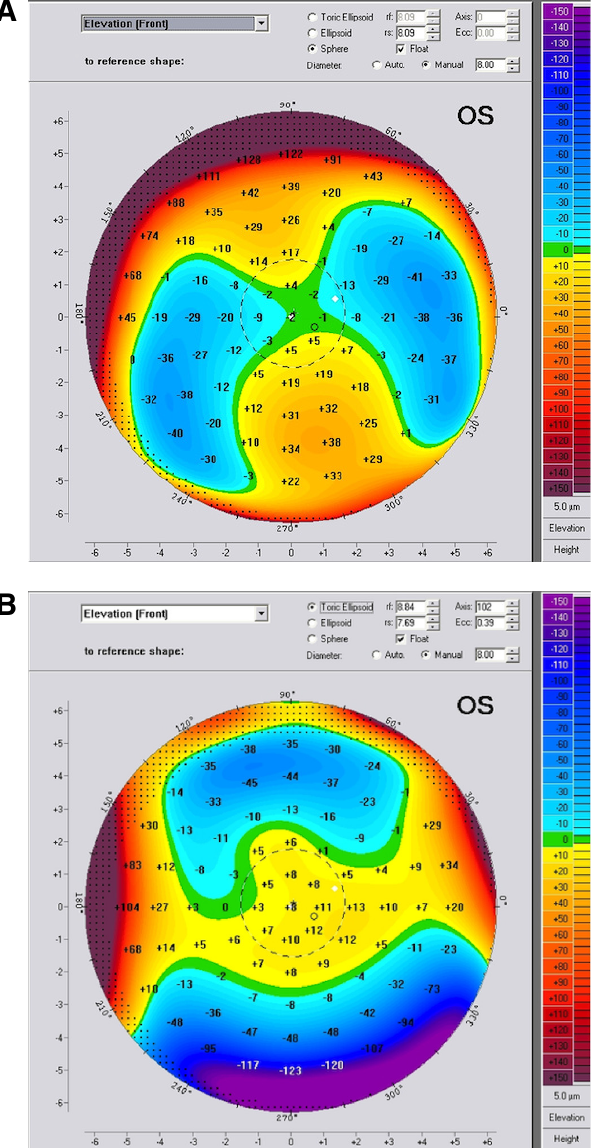
Figure 6. The kissing birds sign on the anterior elevation map. When it exists, it appears on the BFS float mode ( A ), and disappears when switching to the BFTE mode ( B